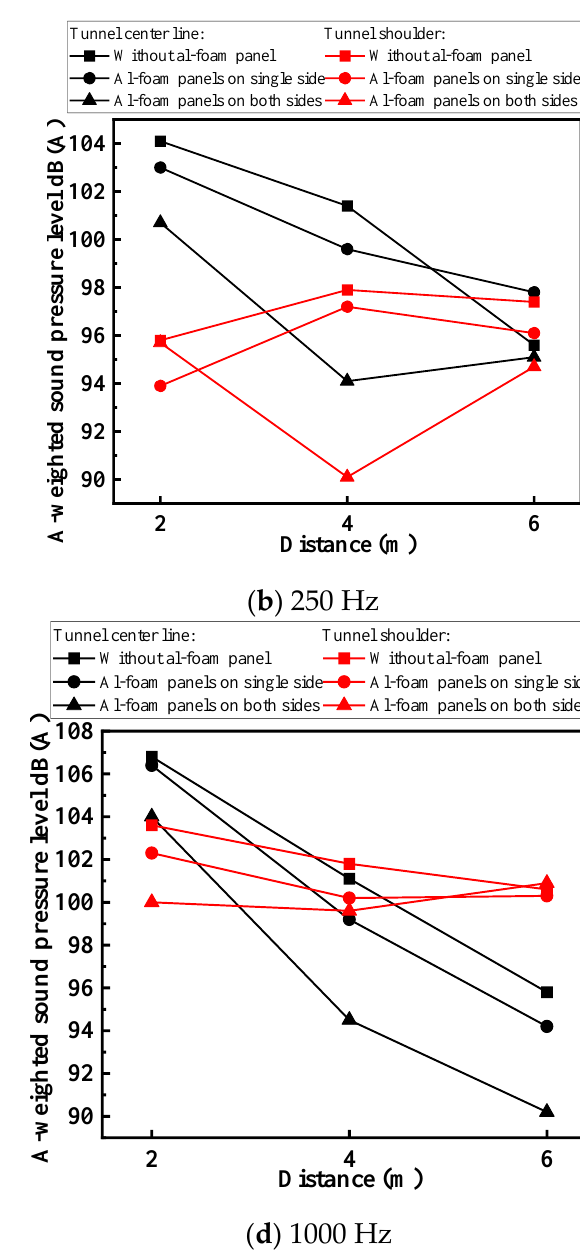
Distance (m) ( e ) 2000 Hz Figure 9. Influence of location and distance.